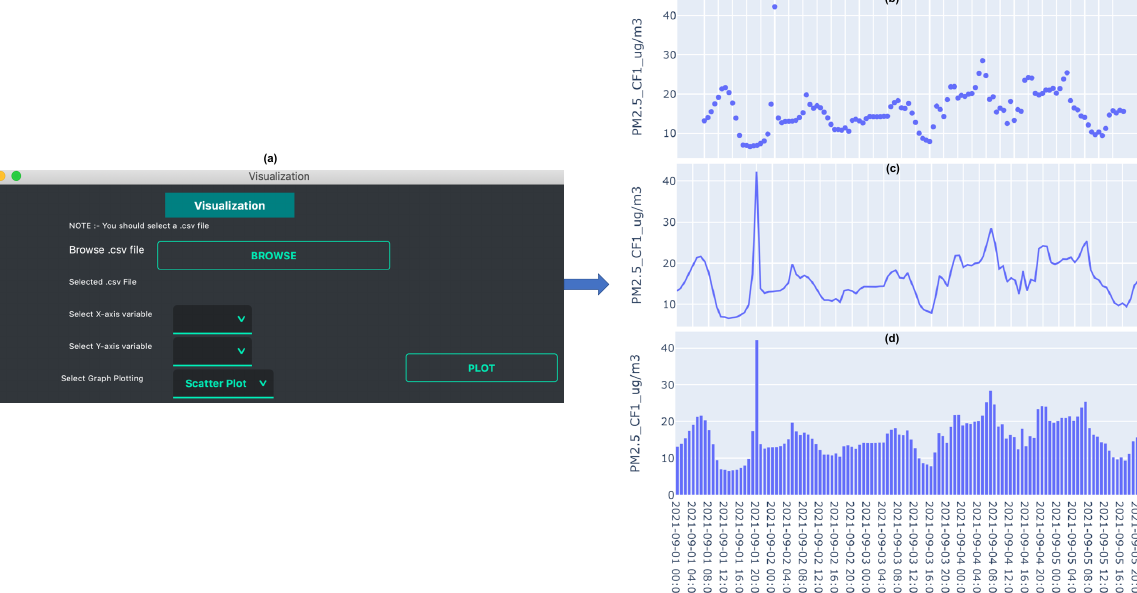
Figure 2. Data visualization example: ( a ) Snapshot of data visualization GUI, ( b ) scatter plot, ( c ) line plot, and ( d ) bar